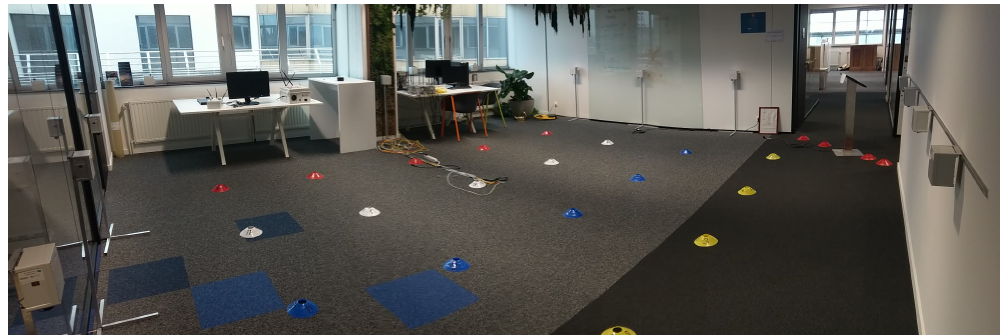
Figure 3. A photograph of the office environment. It should be noted that both the nodes and cones had not yet been placed in their final locations as indicated by the schematic overview in Figure 2.